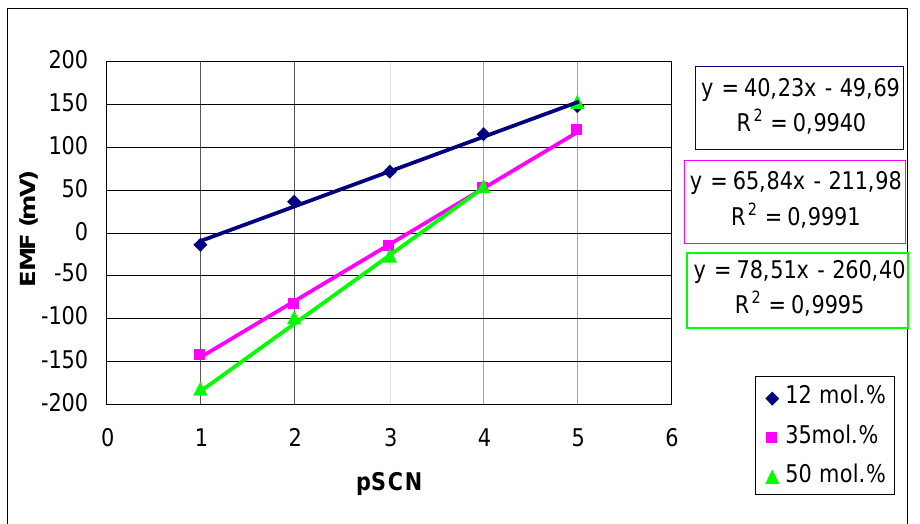
Figure 4. Potentiometric responses of membranes containing ionophore CoTMeOPP in PVC/ o -NPOE